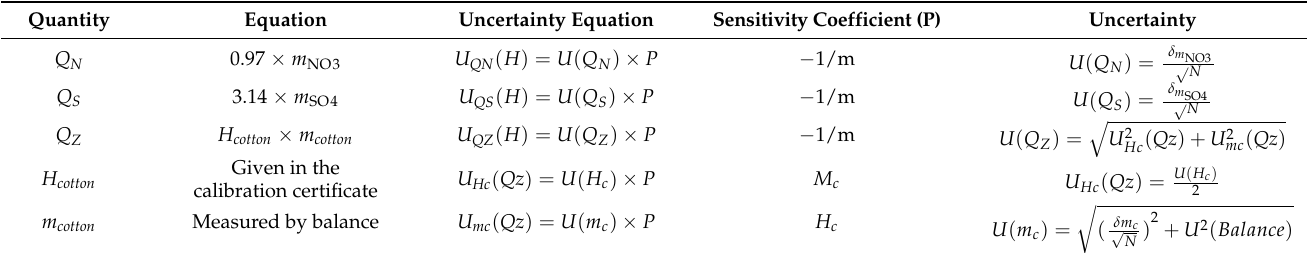
Table 3. The uncertainty equations due to the thermochemical and ignition